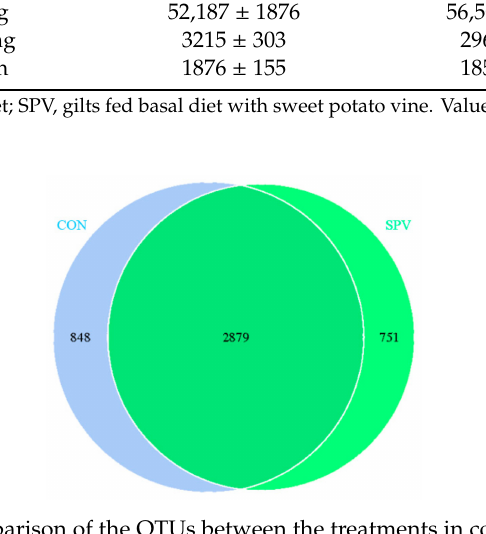
Figure 4. Microbiota comparison of the OTUs between the treatments in colon. CON, gilts feed the basal diet; SPV, gilts fed basal diet with sweet potato vine.